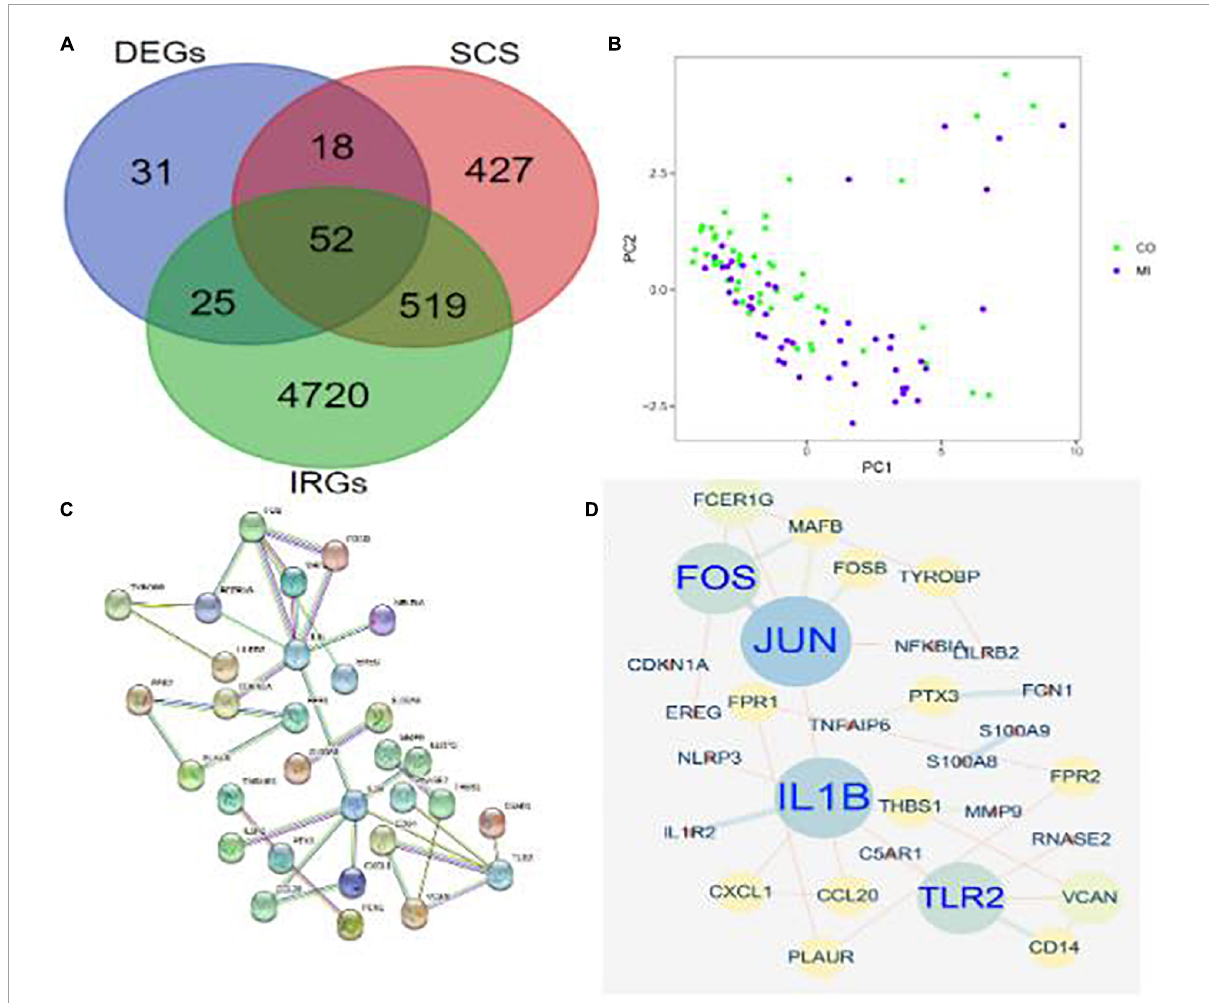
FIGURE4 Identification of co-DEGs in patients with MI. (A) A Venn diagram showed the intersection of obtained DEGs, SCS, and IRGs, where 52 co-DEGs were identified. (B) PCA of co-DEGs showed good differentiation power. (C) A PPI network diagram of 52 co-DEGs was obtained from the STRING online platform. (D) Another PPI network diagram of 52 co-DEGs was constructed using Cytoscape